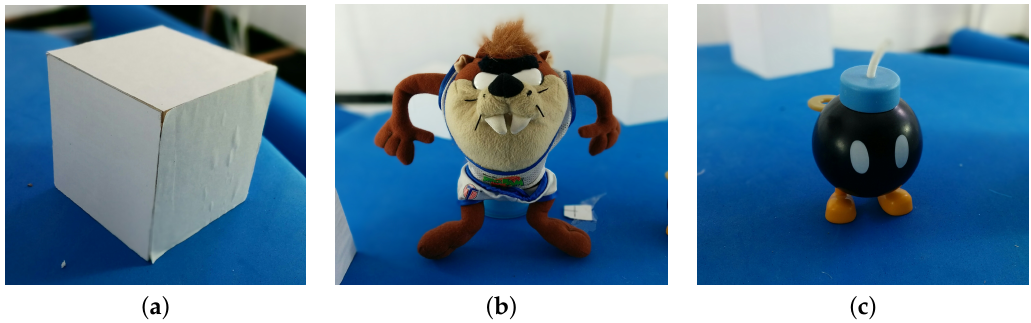
Figure 16. Registered objects. ( a ) Object 1 (Cube); ( b ) Object 2 (Taz); ( c ) Object 3 (Bob-omb).